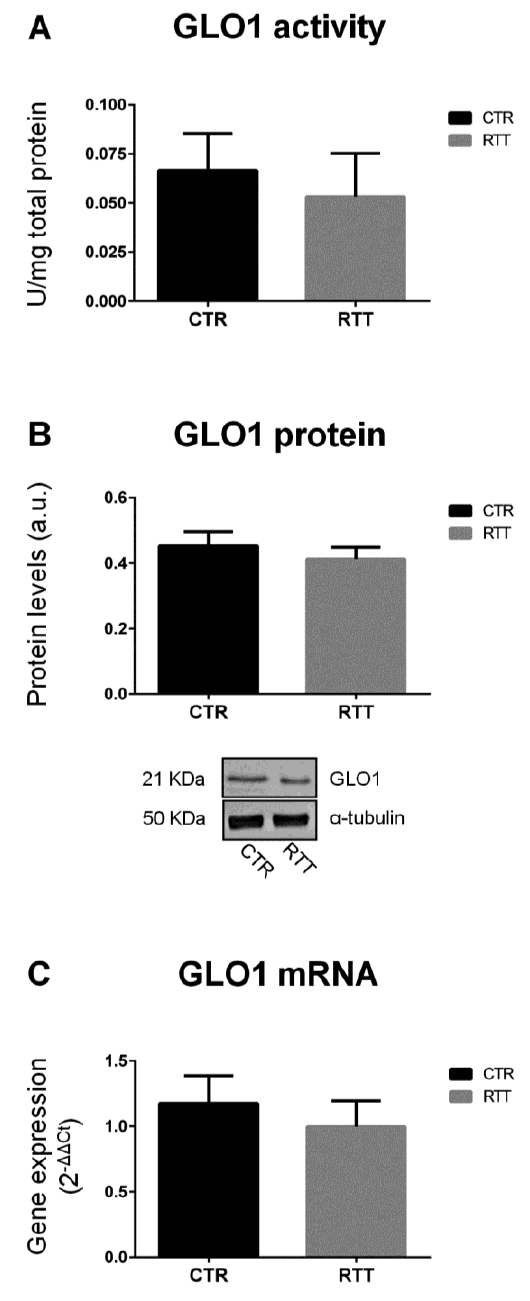
Figure 1. Evaluation of glyoxalase 1 pattern. ( A ) GLO1 specific activity; ( B ) GLO1 protein levels, with representative (inverted) Western blots; ( C ) glo1 gene expression levels. Data of real time RT-PCR were given as 2 − ∆∆ Ct , using rpl13a as the reference, and one of the controls as the internal calibrator. All the data were expressed as means ± SD. CTR, control; RTT, Rett syndrome. Data were analyzed by a t -test for independent groups.